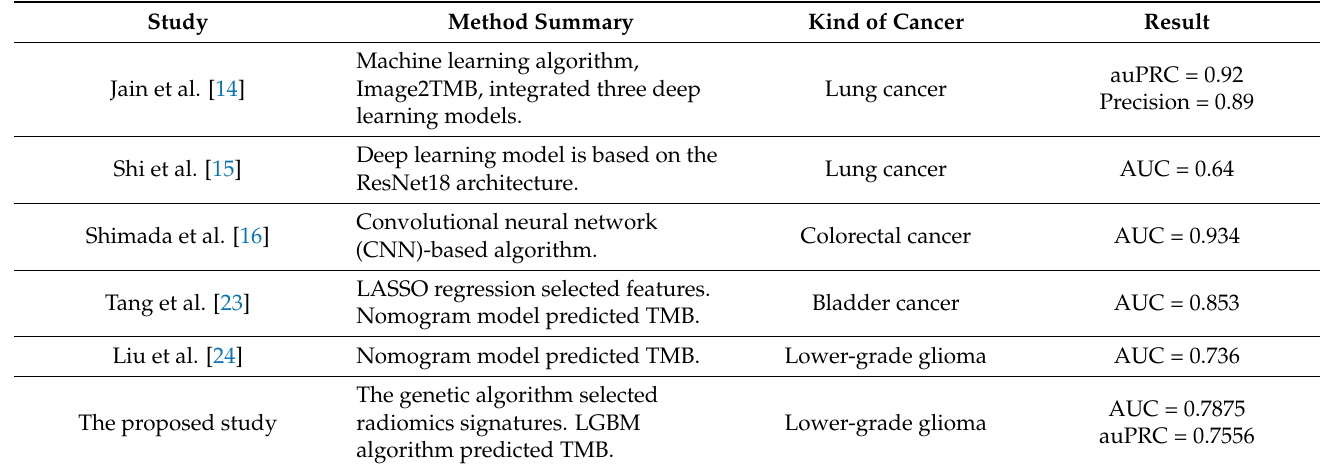
Table 4. Comparison among different studies on TMB